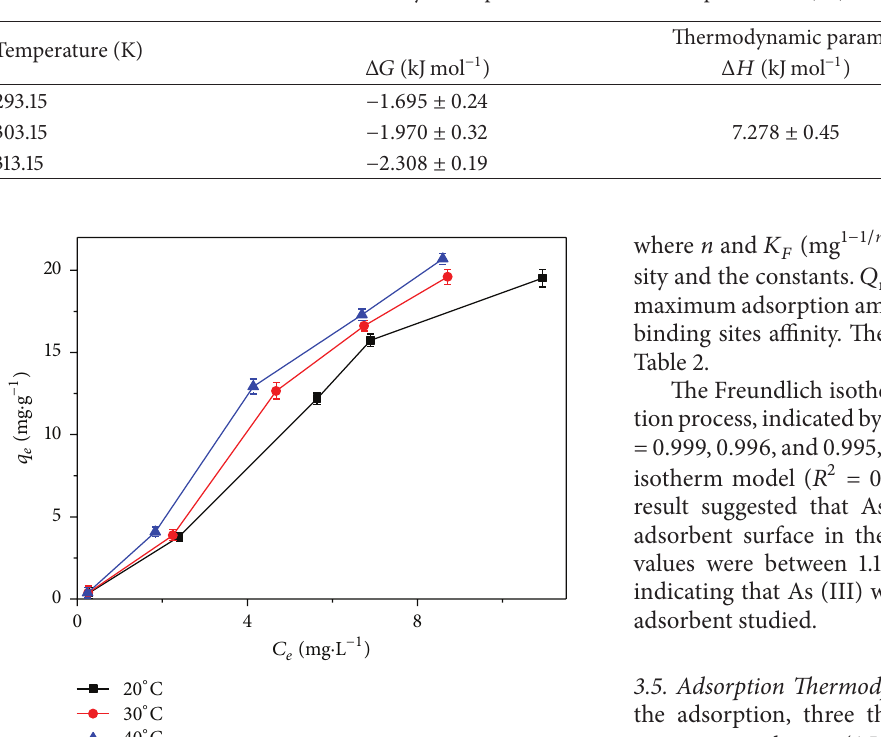
Table 3: The thermodynamic parameters for the adsorption of As (III) on the adsorbent.